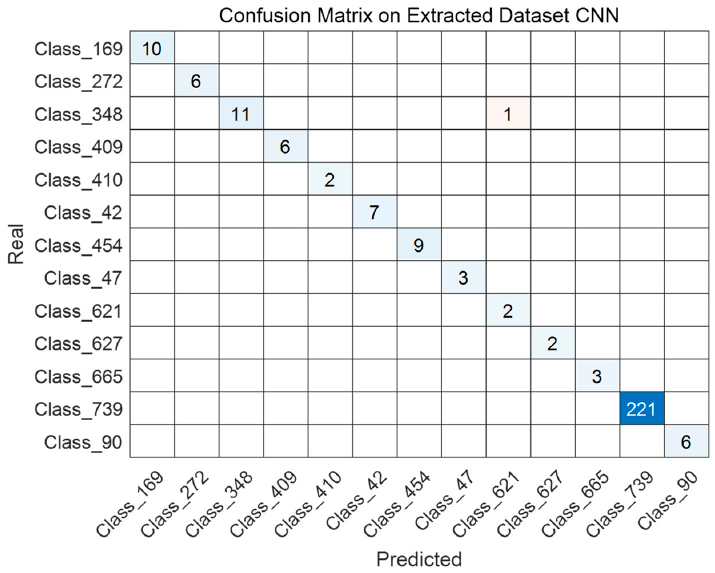
CNN, 13 classes are obtained, and the confusion matrix of the validation dataset is shown in Figure 14.